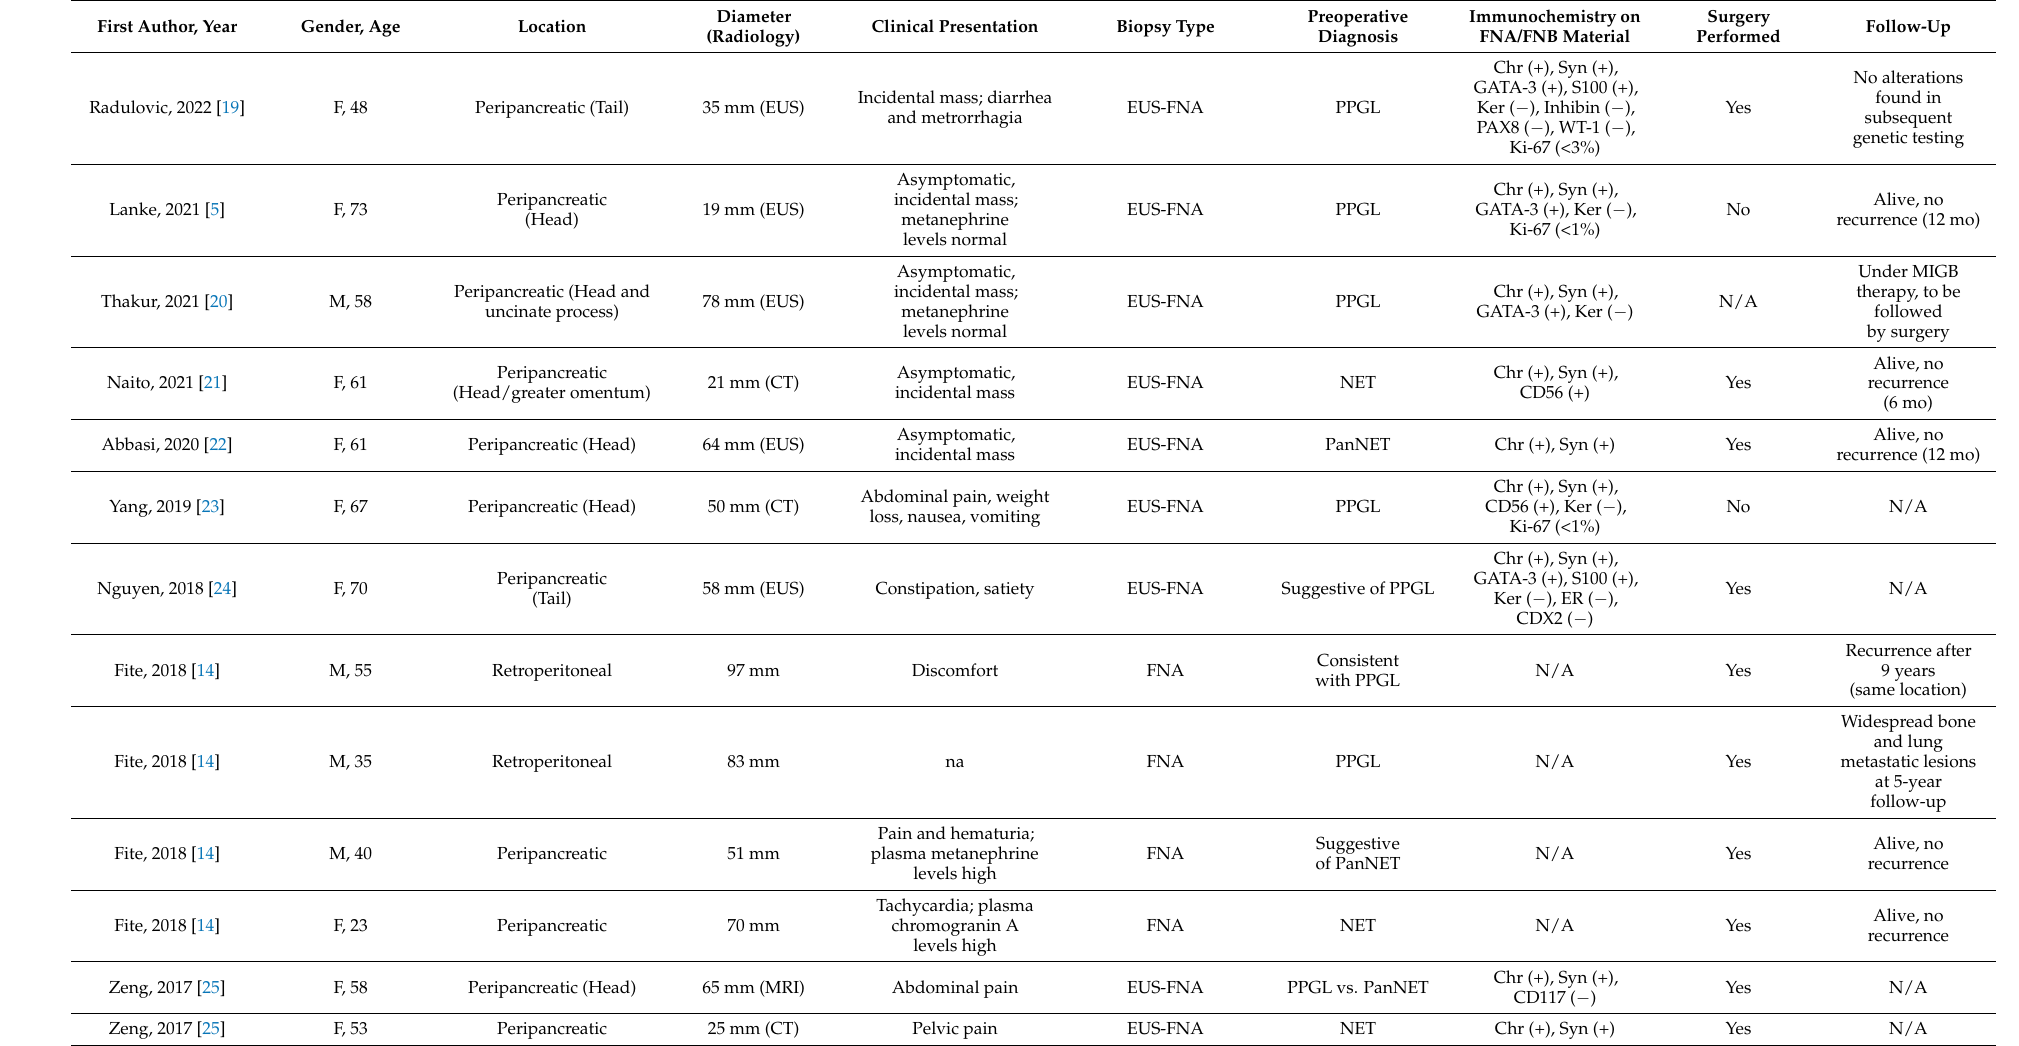
Table 1. Literature review (2000–2022) of abdominal extra-adrenal paragangliomas diagnosed with FNA or